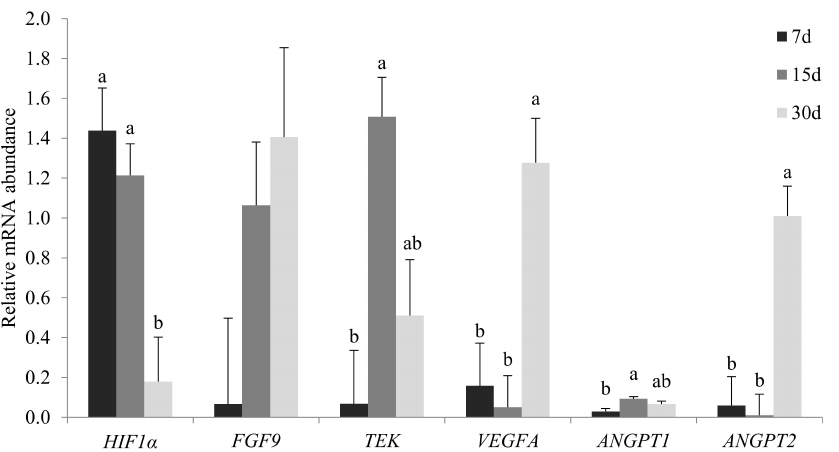
Figure 3. RTA of the HIF1 α , FGF9, TEK, VEGFA, ANGPT1, and ANGPT2 genes according to gestational age in commercial and Piau breed gilts. Different letters indicate differences at p < 0.05.